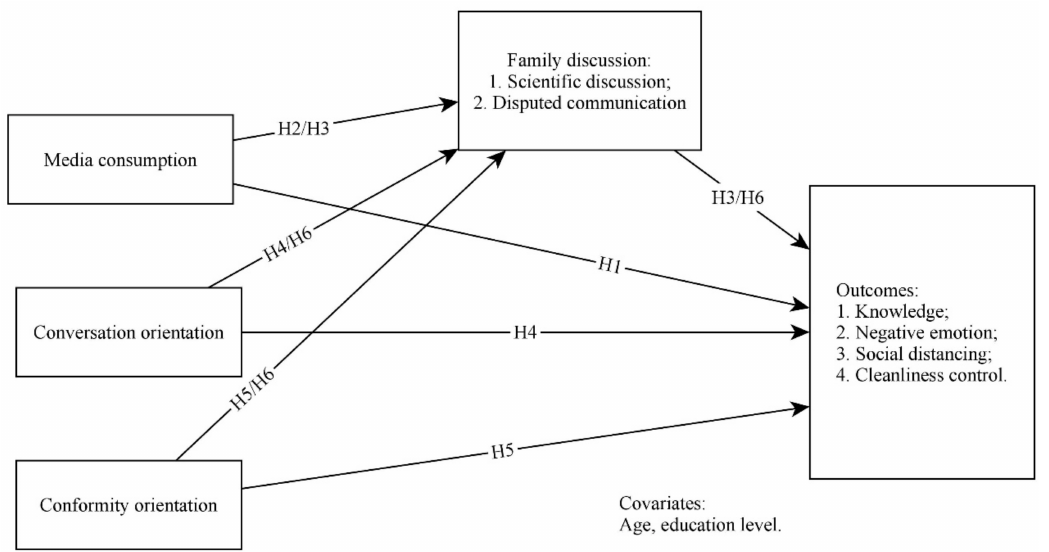
Figure 1. Research